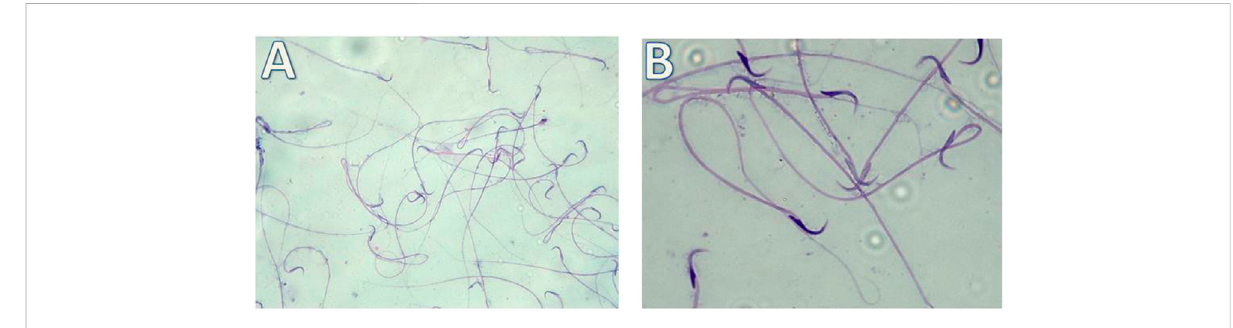
FIGURE 7 Micrograph illustrating the morphology of sperms of control albino rat Showing normal sperms (H&E; (A) -X200, (B) -X400)